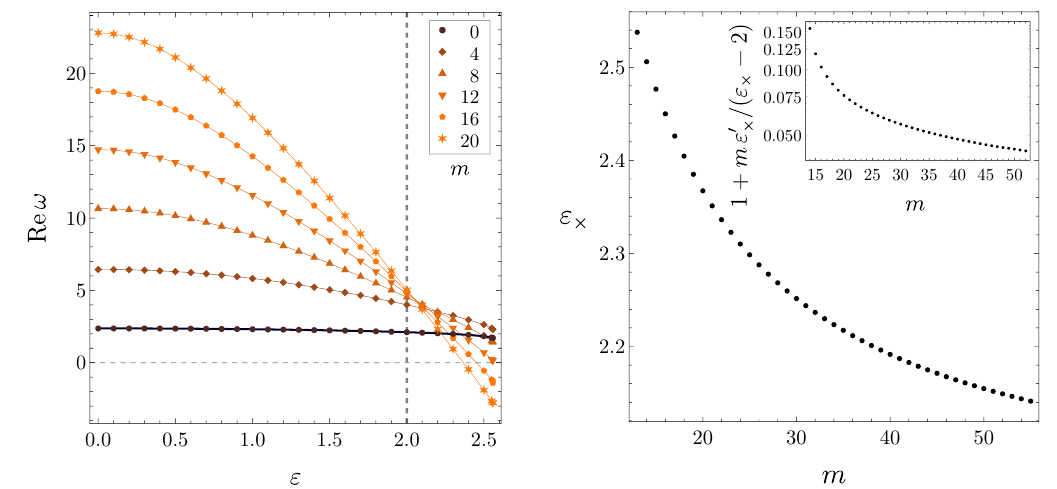
Figure 16 . Left : real part of quasinormal mode frequency with ‘ = m against the boundary rota- tion parameter " , for small black holes with T = 1 =(cid:25) . At " = 0, these reduce to the Schwarzschild- AdS 4 values. The bold dashed gridline shows the critical " = 2 value. Right : rotation amplitude where the zero-mode is for a given m , against m . The inset shows the logarithmic derivative of " (cid:2) . We expect that in the limit m ! 1 , " (cid:2) !